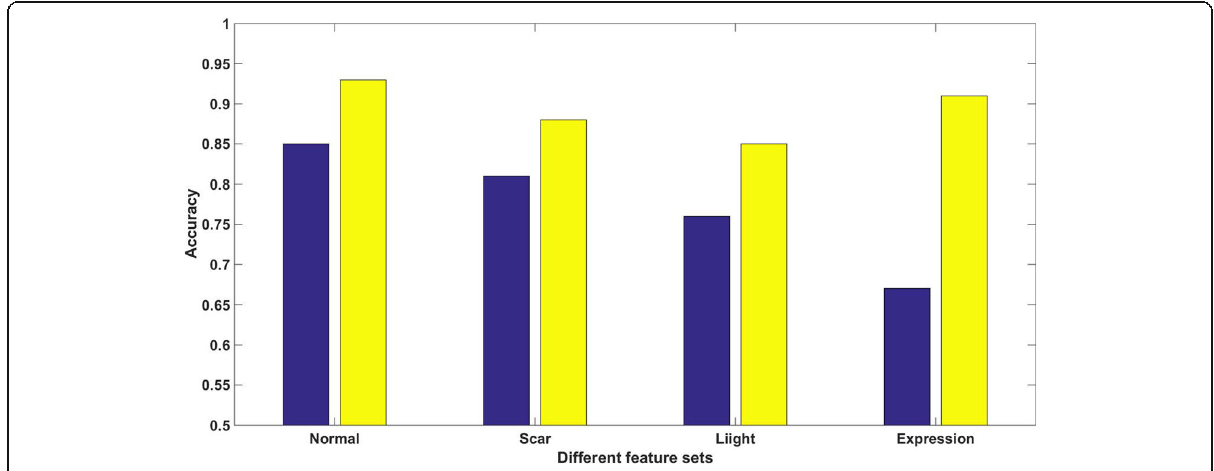
Fig. 8 The recognition results before and after K-mean